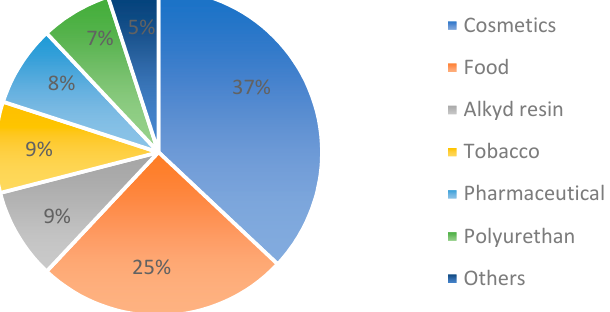
Figure 1. Distribution of major applications of glycerol in various literature reports [9].